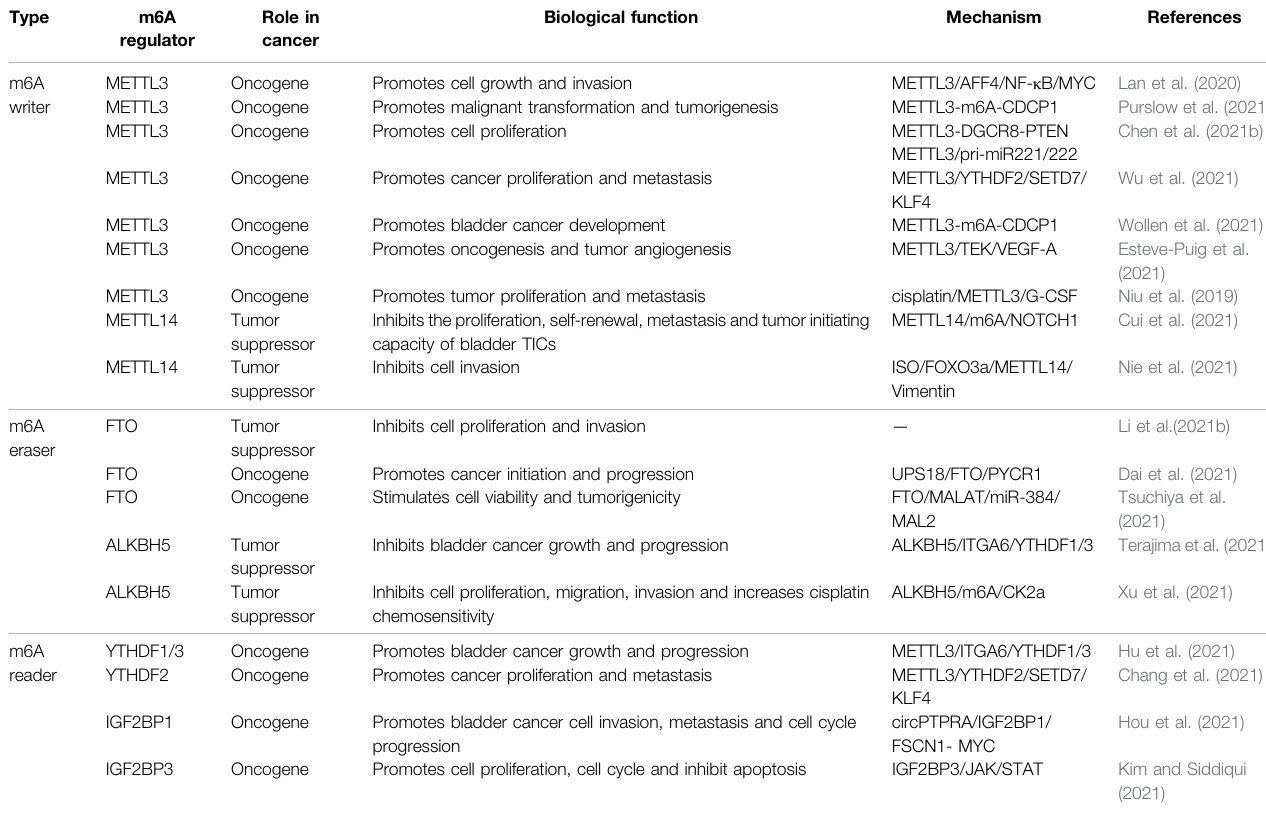
TABLE 1 | The role of RNA m6A modi fi cation in bladder